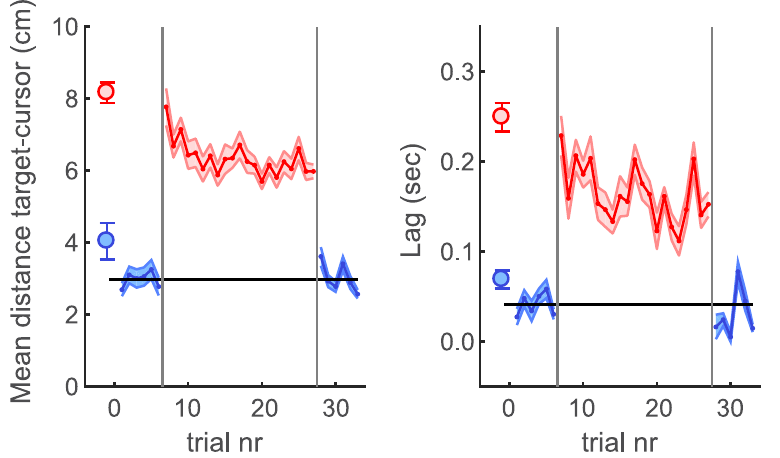
Fig 4. Behavioural results of the tracking task. The left panel shows the average distance between the target and cursor across the last 18 seconds for each trial. The right panel shows the visual movement time lag between the target and cursor. Blue lines (mean across participants) and shaded areas (standard error of the mean) represent the results for the no-delay trials during the pre- and post-test in the experiment. Red lines and shaded areas represent trials during the exposure phase in which the additional feedback delay of 200ms was present. The black horizontal line represent the average across the first six trials in the experiment (no-delay pretest) as a visual reference for investigating both direct effects of the added feedback delay as well as potential adaptation aftereffects in the post-test. The vertical grey lines represent the beginning and end of the delay exposure phase. The blue and red circles on the left-hand side represent the average results for the No-Delay and Delay conditions in the Methods Test part of the experiment for comparison.